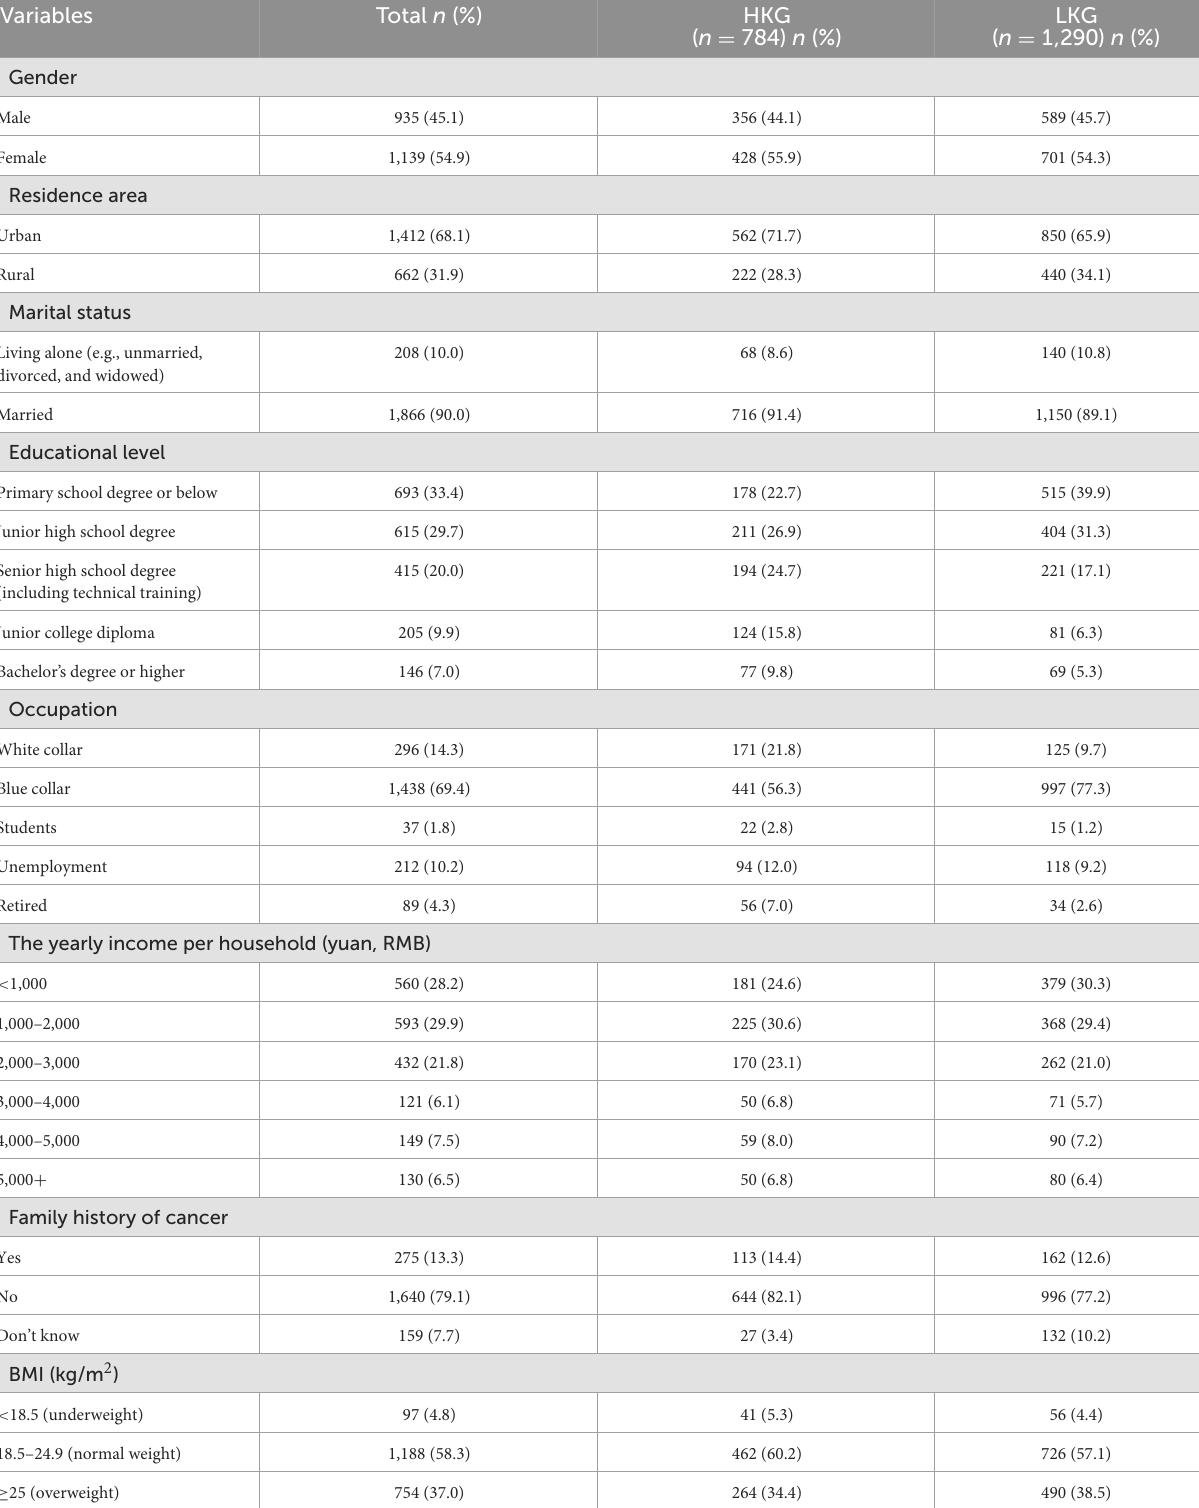
TABLE 1 Rates of core knowledge level by demographic characteristics of participants ( n =